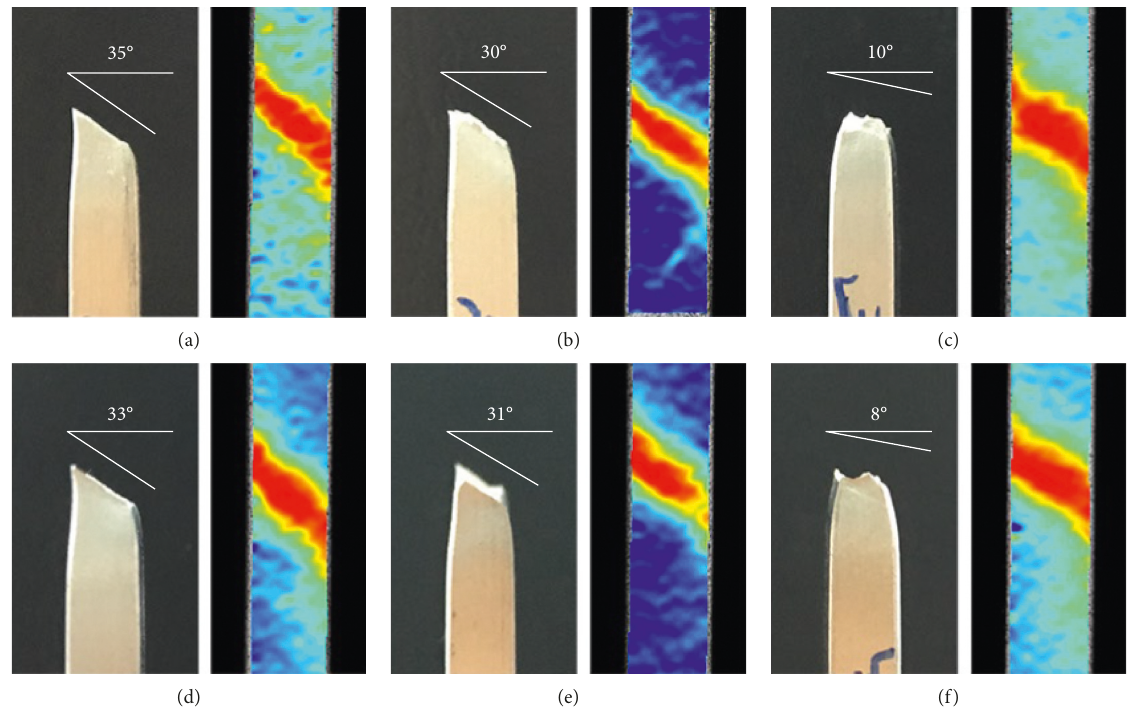
Figure 8: Optical macrograph of the side view of fracture surface and the corresponding strain field at the beginning of yielding for